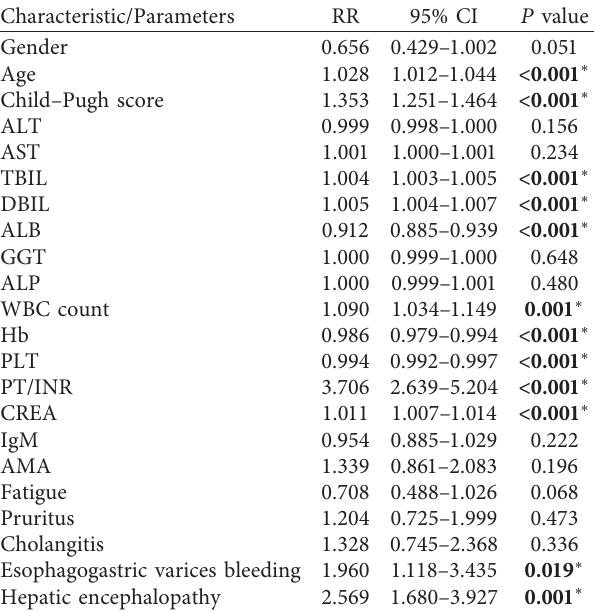
Table 4: Univariate Cox proportional hazards regression analysis of prognostic factors for overall survival of patients with primary biliary cholangitis.